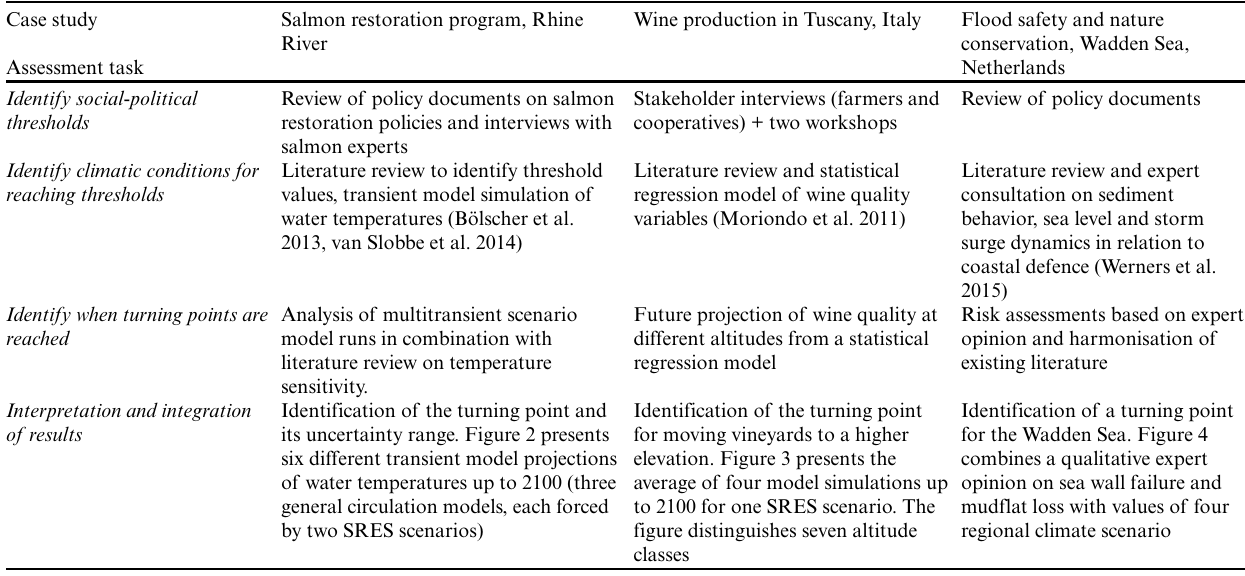
Table 1 . Methods used in case study to assess adaptation turning